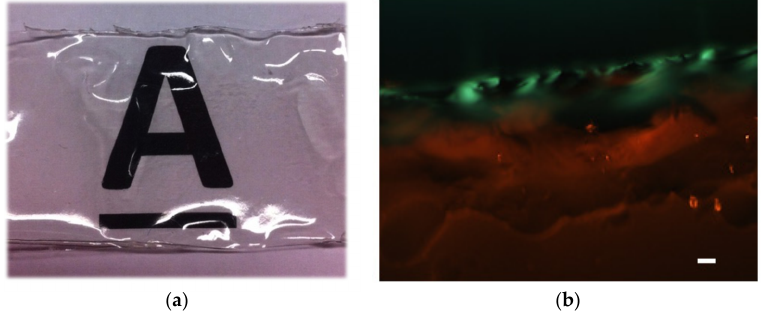
Figure 5. ( a ) Transparent keratin film obtained by 14 cycles of diafiltration (the image was taken by a camera). ( b ) Congo red stained keratin film (obtained by 14 cycles of diafiltration) between crossed polarizers, which shows apple ‐ green birefringence. Scale bar: 5 μ m.